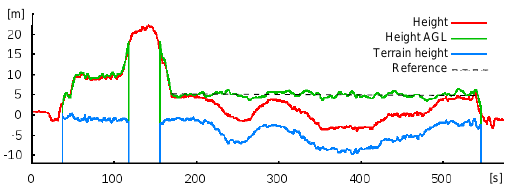
Figure 4: Helicopter height during a terrain following flight.